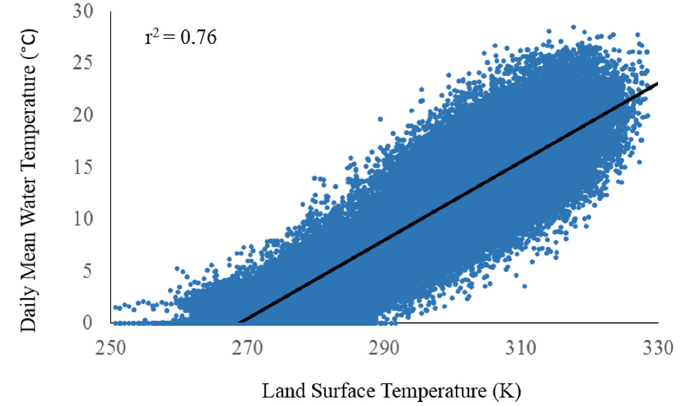
Figure 5. Relationship between Daily Mean Water Temperature (°C) and Land Surface Temperature (K) for all sites, 2000–2009 in the John Day River basin. The black line and r 2 are from a simple linear regression (DMWT ~ LST).